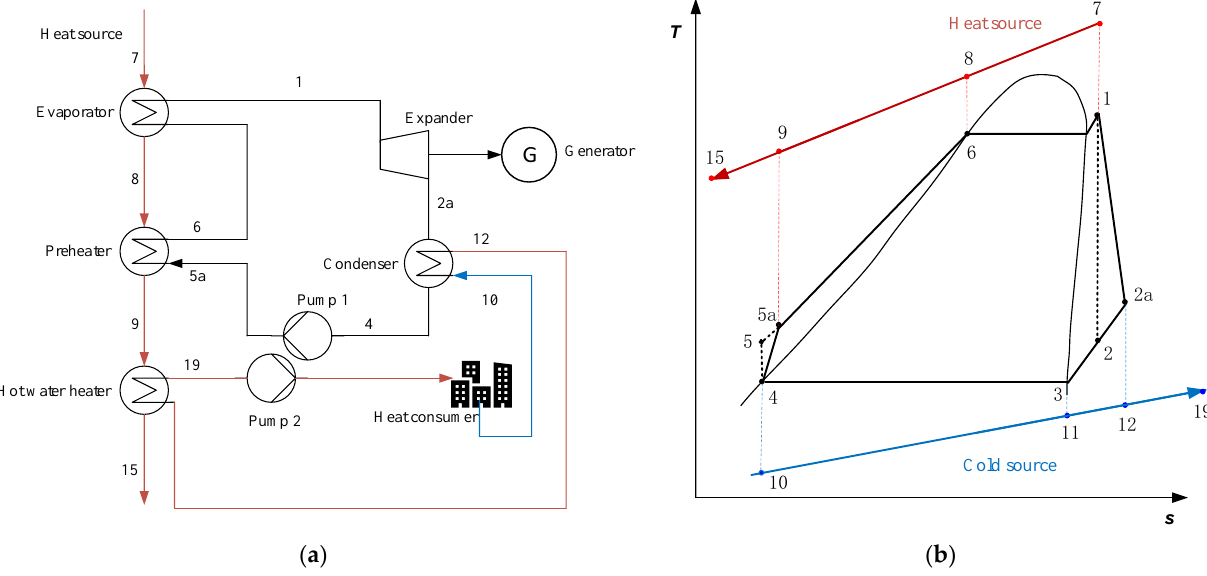
Figure 4. Cycle configuration and T -s diagram of the serial/condensation system: ( a ) cycle configuration and ( b ) cycle T -s